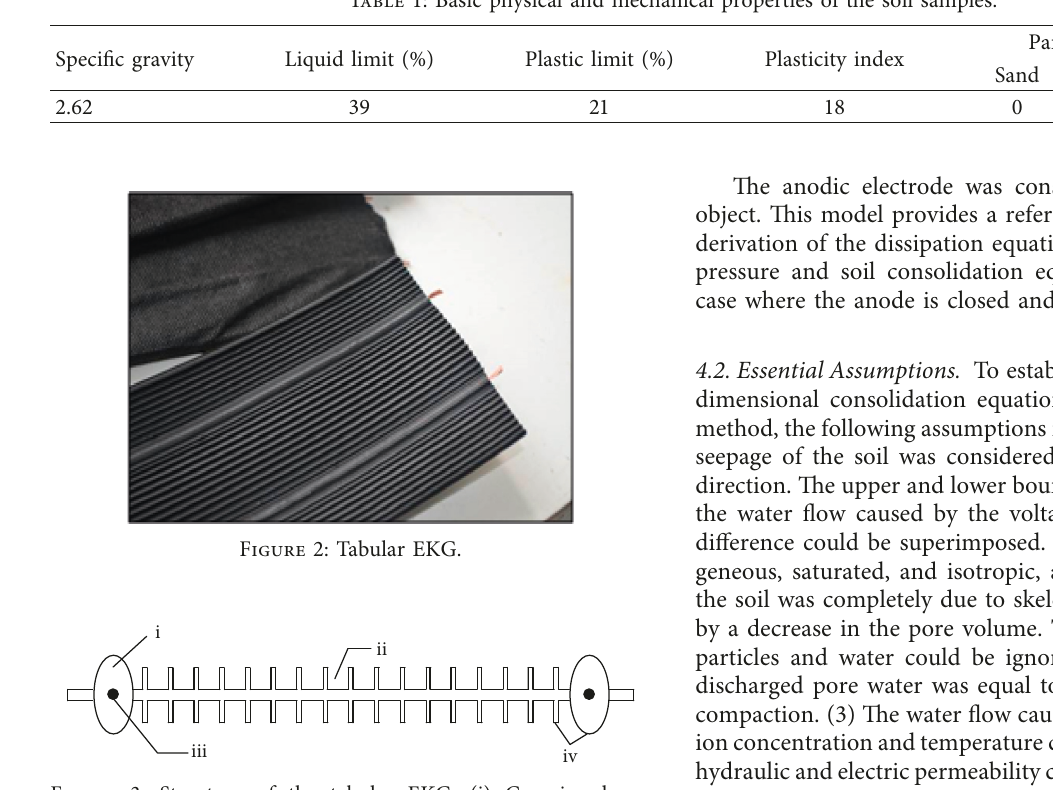
Figure 3: Structure of the tabular EKG. (i) Covering layer, (ii) drainage groove, (iii) copper wire, and (iv) conductive